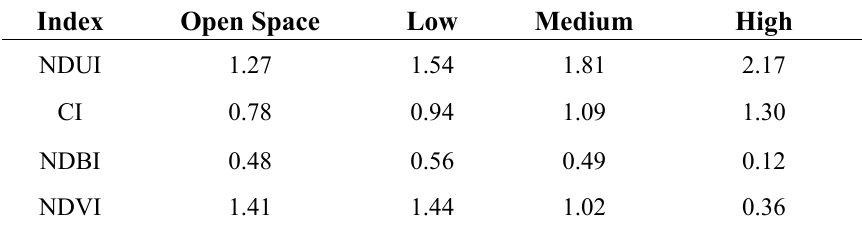
Table 2. Separability between the barren land class and the Developed classes as measured by Spectral Discrimination Index (SDI) generated from different indices.